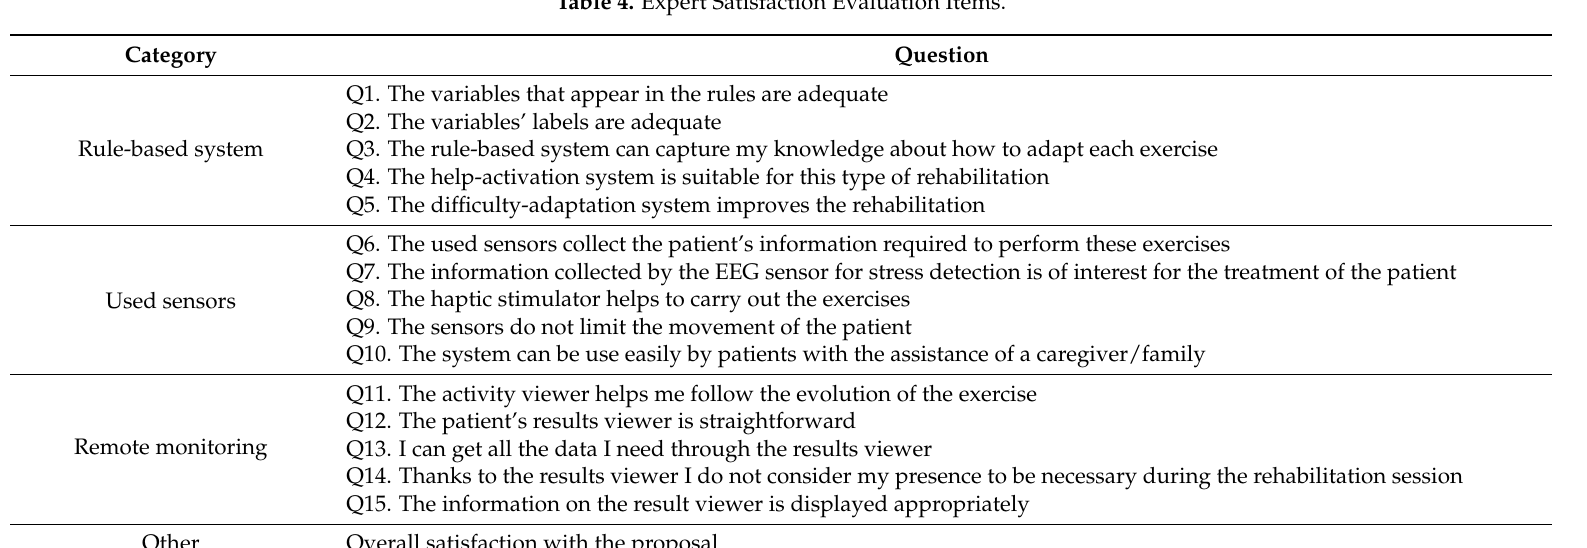
Table 4. Expert Satisfaction Evaluation